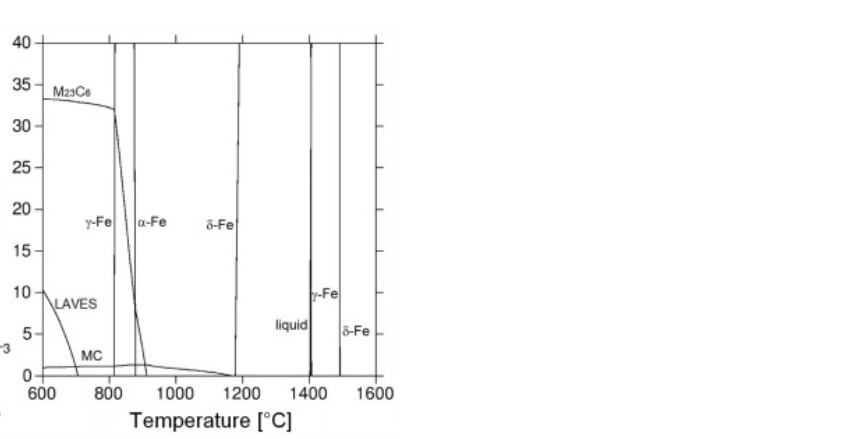
Figure 13. The effect of various heating up and cooling down conditions of the rejuvenation heat treatment at 700 °C for 1 h on ( a ) hardness and ( b ) impact toughness.